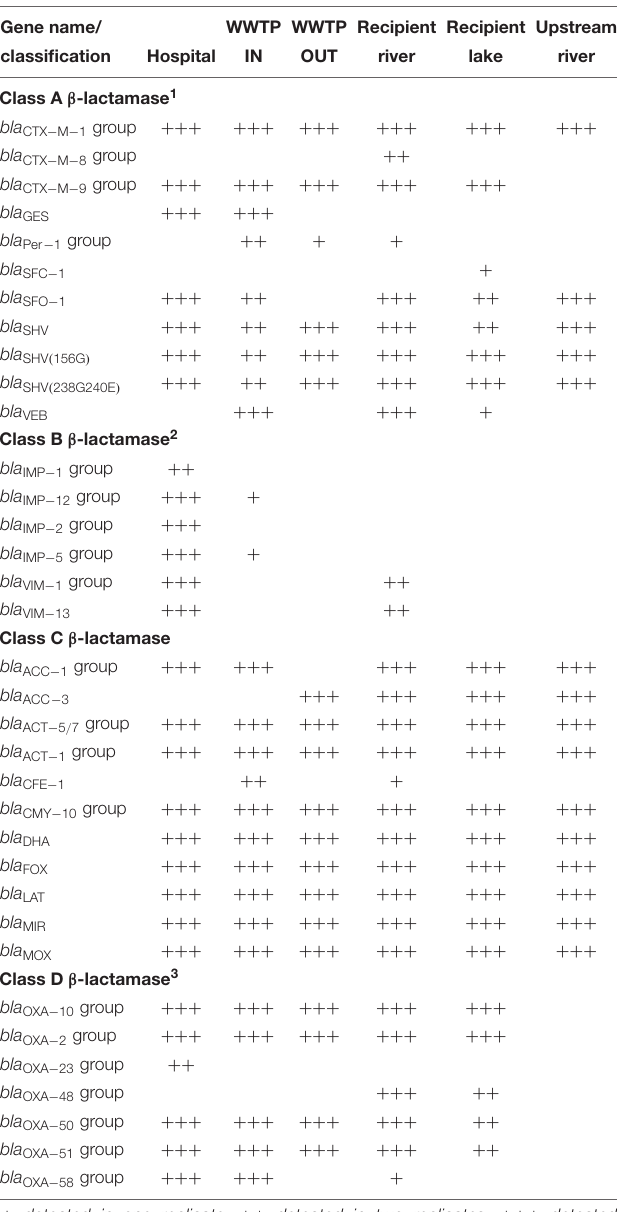
TABLE 2 | β -lactamase genes identified in samples from hospital wastewater, WWTP, river, and lake water in Sweden.